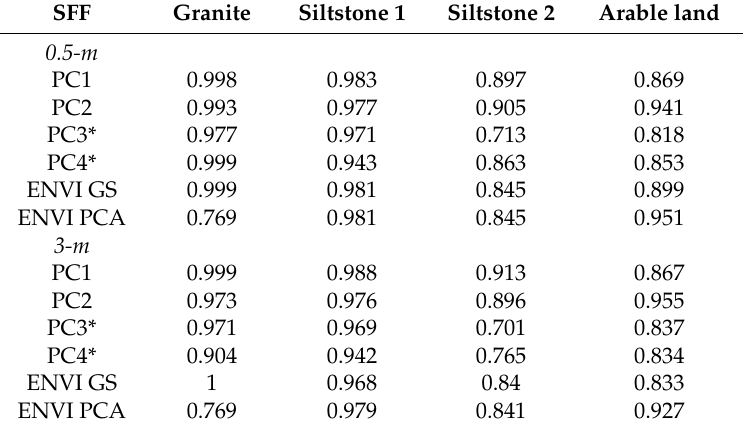
Table 13. SFF scores achieved when comparing the ASTER reference and the fused image spectrum. The higher the score the higher the match (0: no match, 1: identical spectrum). It was expected that the first two PCs have the potential to give good results when employing the PCA sharpening process, however PC3* and PC4* were used to compare the result and explain it in a wider context. SFF Granite Siltstone 1 Siltstone